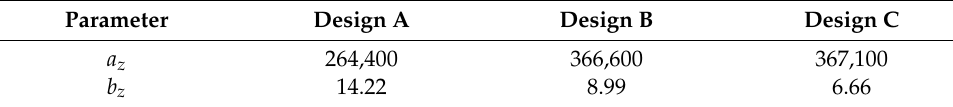
Table 4. Parameter values of levitation stiffness.